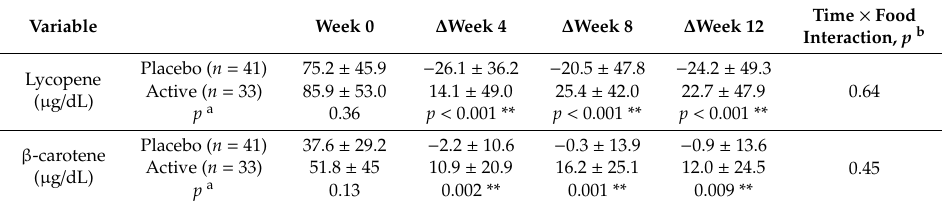
Table 6. Serum carotenoid levels for the placebo and active food test groups.